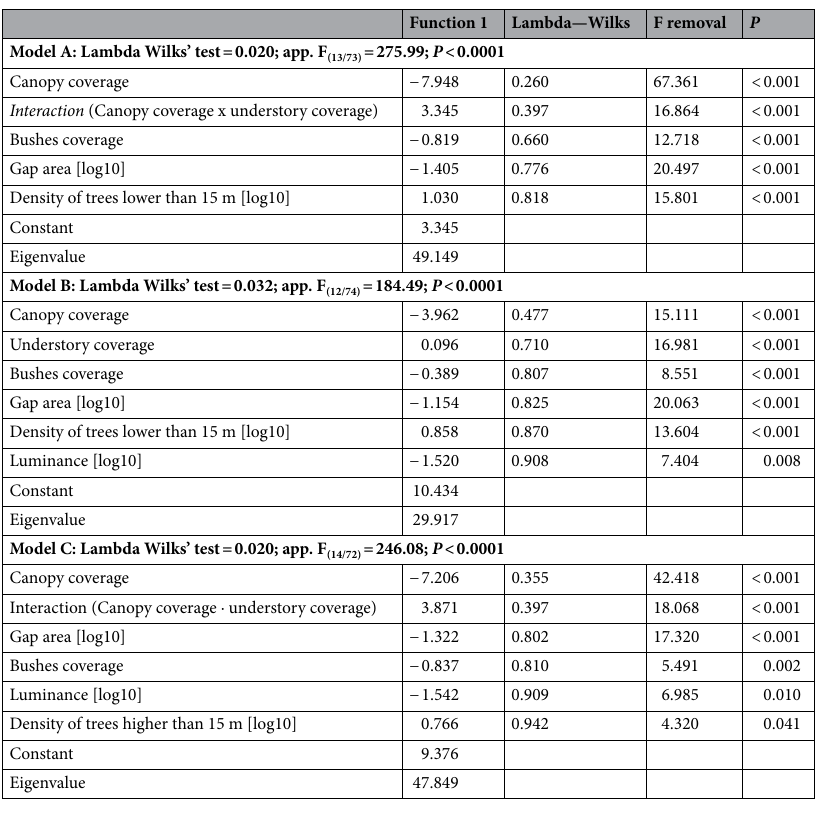
Table 1. Models of discriminant analysis to separate the territories of the Slate-throated Whitestart and Spectacled Whitestart based on the descriptions of vegetation, luminance, humidity and